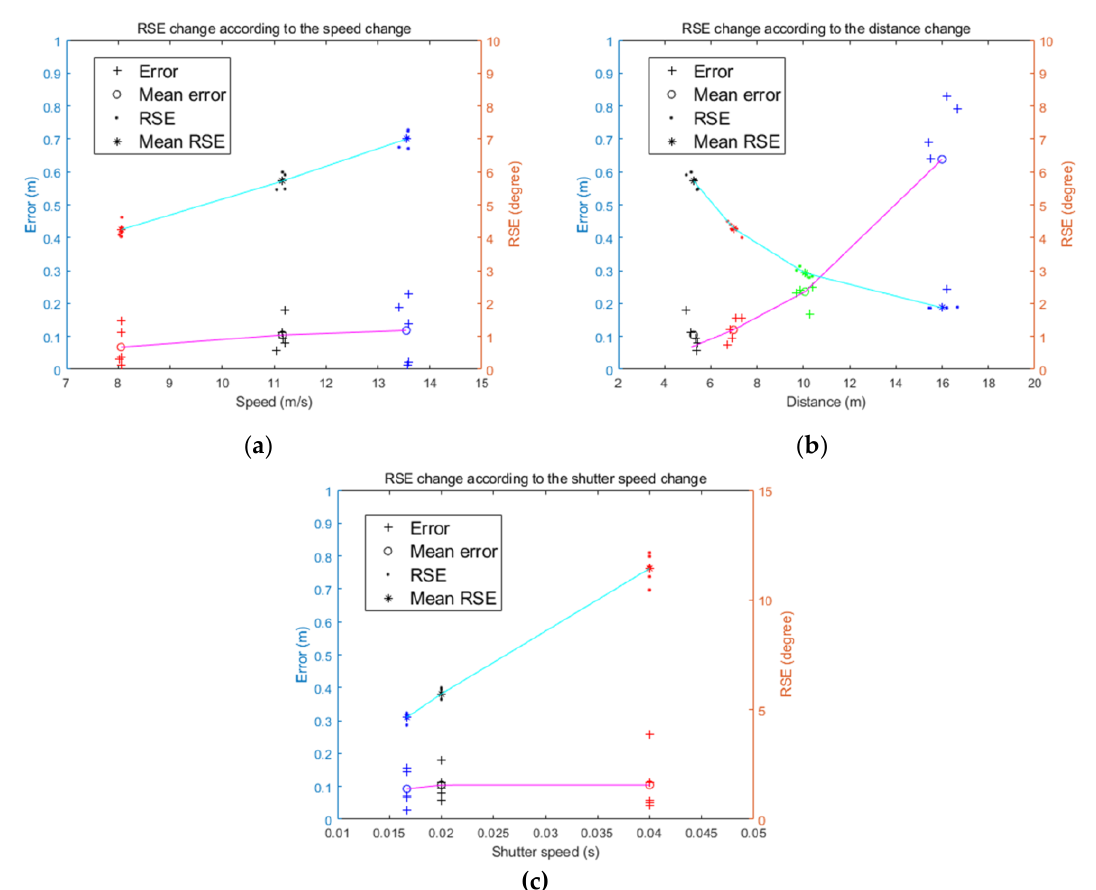
Figure 15. Field test results: ( a ) RSE and error change according to the speed change; ( b ) RSE and error change according to the distance change; and ( c ) RSE and error change according to the shutter speed change.